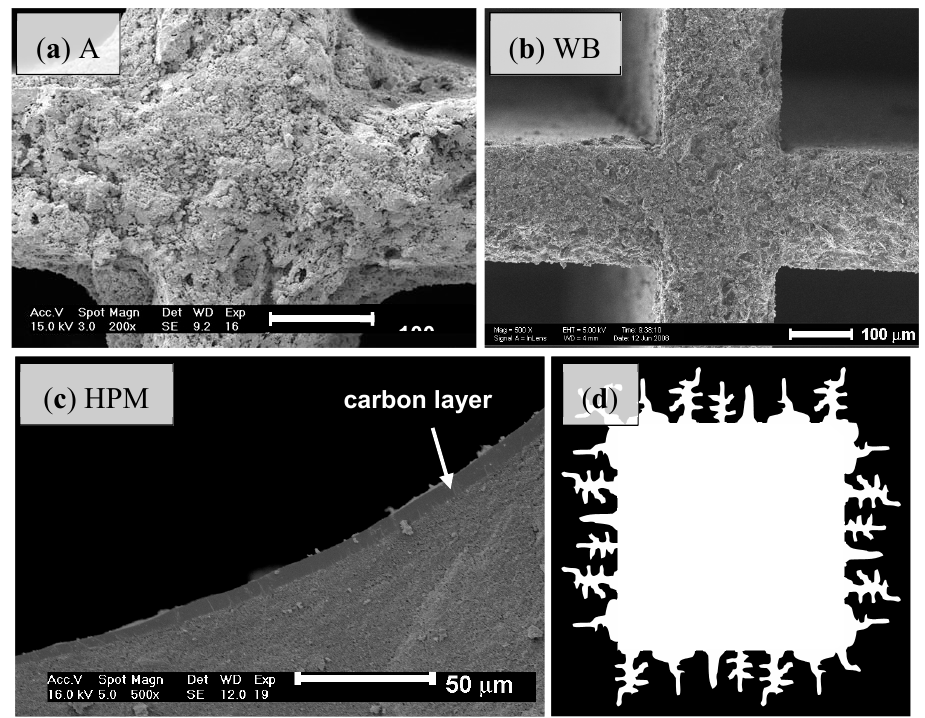
Figure 6. SEM micrographs of the monolith channels: details of ( a ) γ -Al 2 O 3 layer; ( b ) carbon/ceramic composite and ( c ) carbon coating. ( d ) Model of the porosity developed for carbon-based monoliths. Figures reprinted with permission from [60,62,63]. Copyright 2008, 2009,